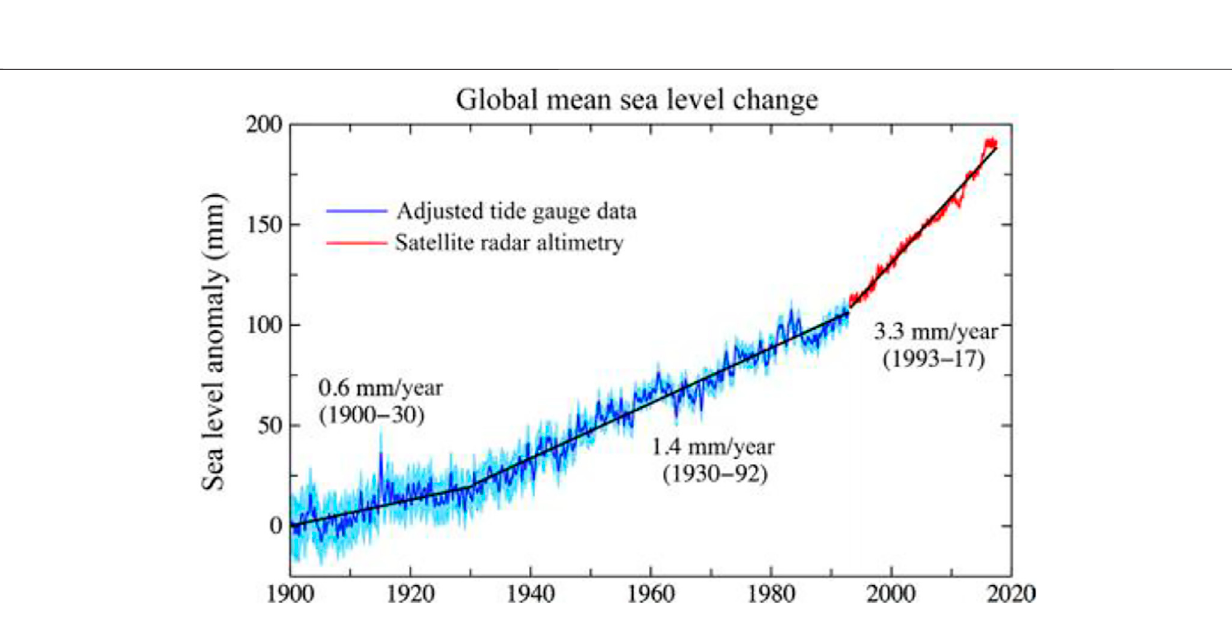
Frontiers in Environmental Science |